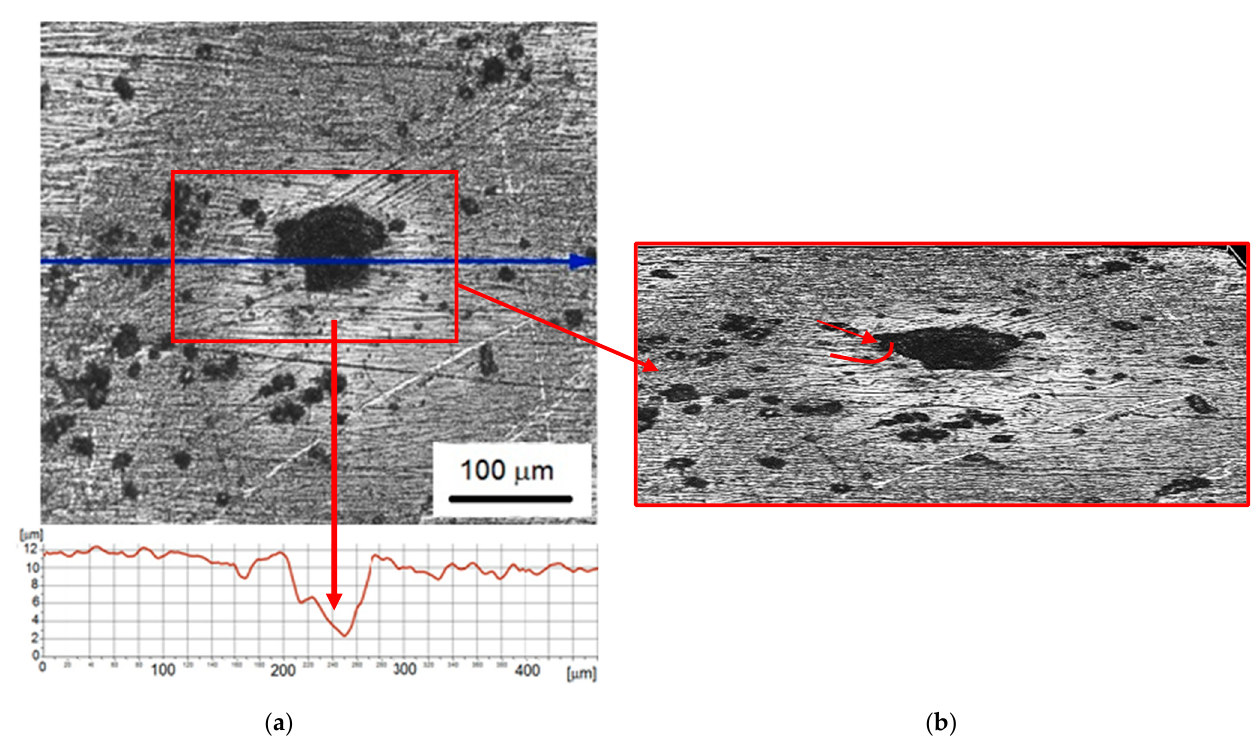
Figure 9. Nickel coating after 60 min of the cavitation erosion tests: ( a ) surface morphology with roughness profile along the selected measurement line; ( b ) 3D surface